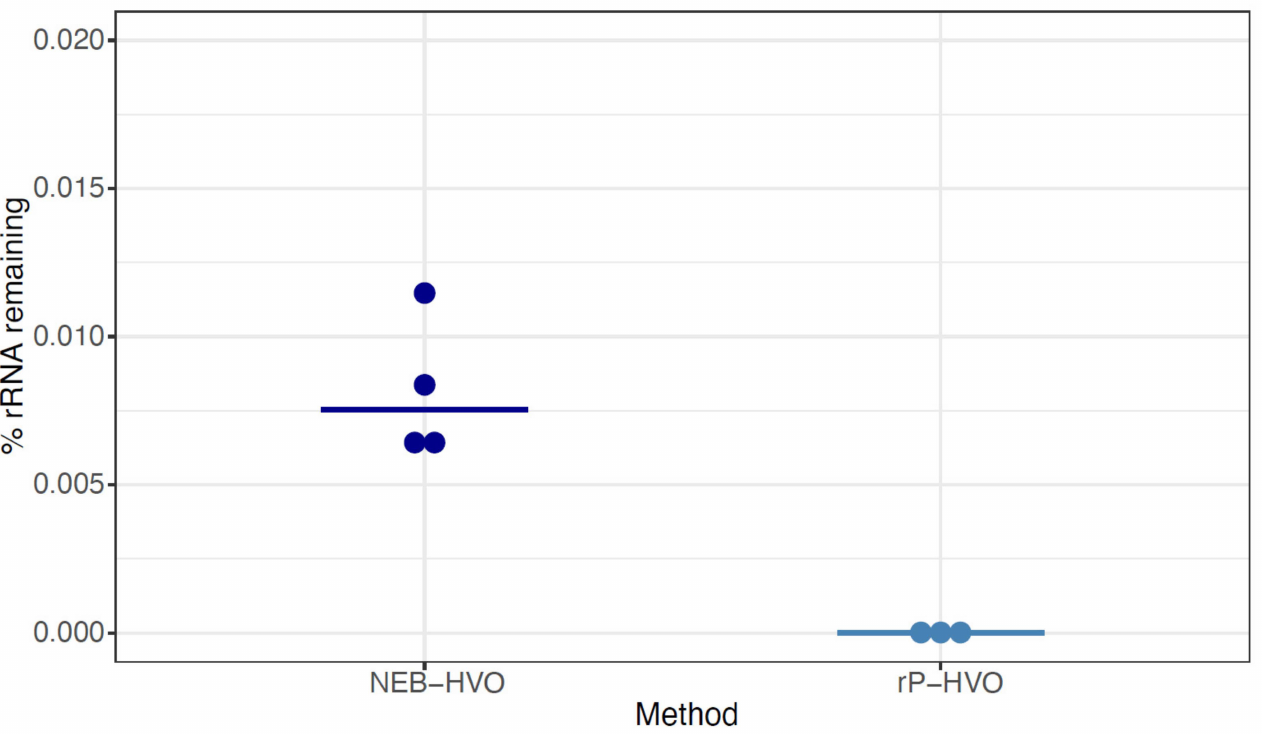
Figure 5. Species-specific probes efficiently remove rRNA from target species. Dotplots showing the percentage of rRNA remaining after using probes with sequences specific for Hfx. volcanii (HVO) rRNA. Dark blue dots represent %rRNA remaining in individual replicate samples depleted with NEBNext Core Reagent Set (“NEB-HVO” method). Light blue dots represent %rRNA remaining in individual replicate samples depleted with the siTools RiboPool kit (“rP-HVO”). Horizontal bars represent the median